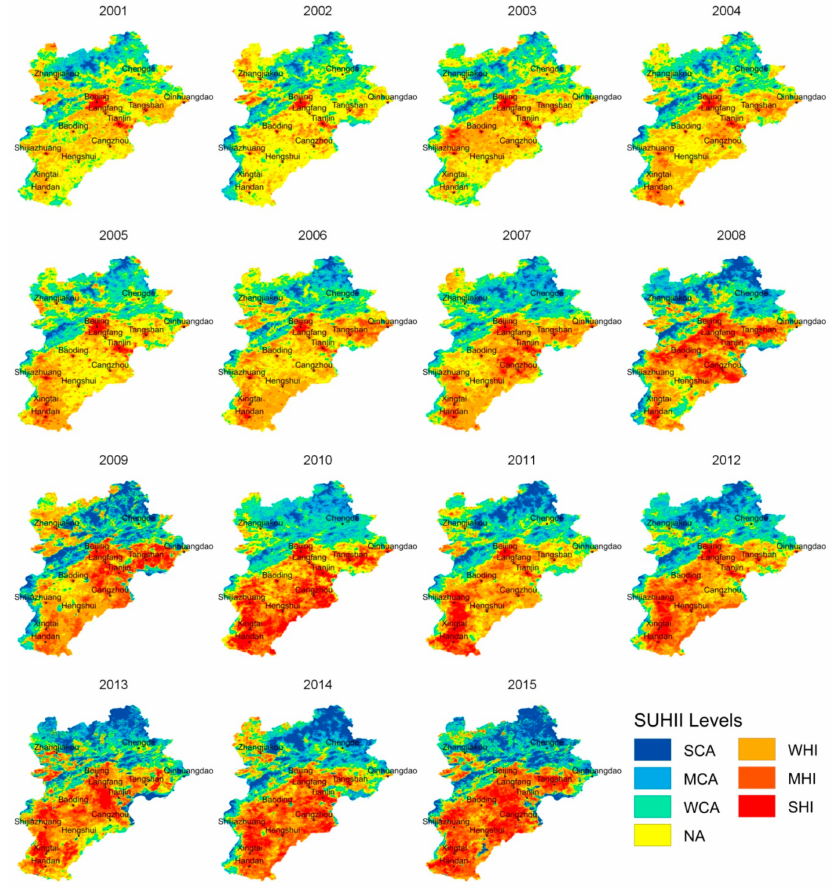
Figure 2. The overall dynamics of the Beijing-Tianjin-Hebei (BTH) thermal